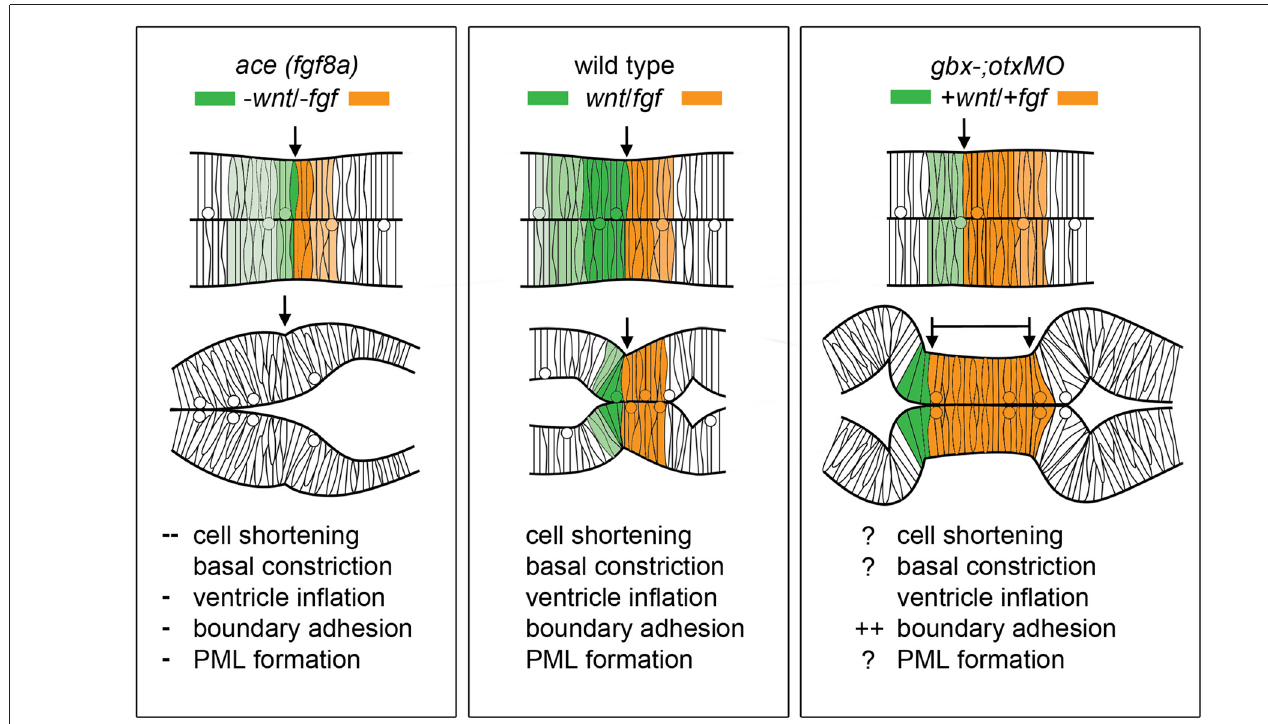
FIGURE 4 | Modulation of Wnt/Fgf signaling and effect on MH morphology. (Left) Summary of wnt/fgf expression domains, MH morphology, and morphogenetic cell behaviors in ace mutants. (Middle, Right) The same model shown for wild-type embryos and otx/gbx loss of function embryos. Figure drawn based on data found in Su et al. (2014). Deficient cell behaviors are indicated with a minus sign ( − ), while overactive cell behaviors are indicated with a plus sign